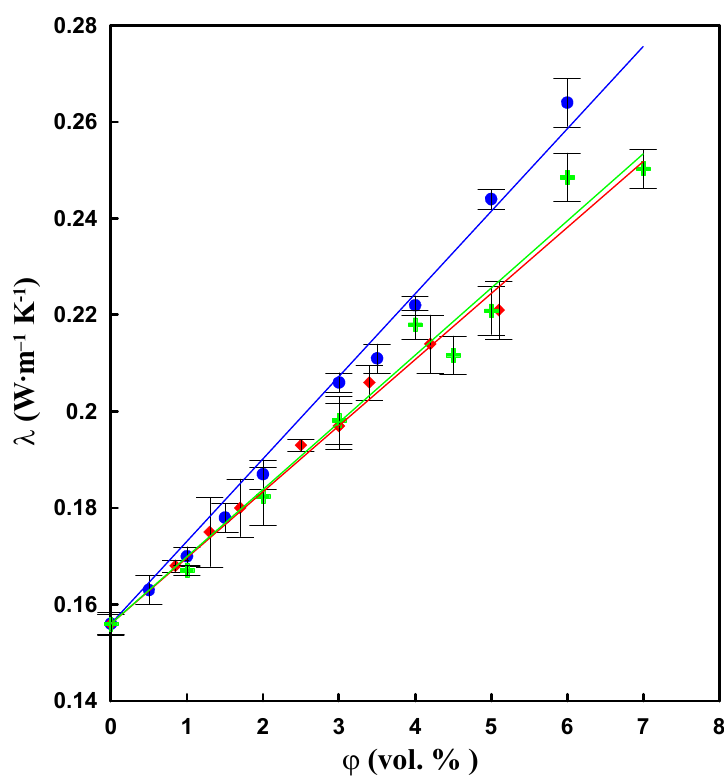
composite ( • mechanical mixing, + sonication) and CNT–DBSA/silicone composites ( ♦ sonication). Experimental data fitted by linear